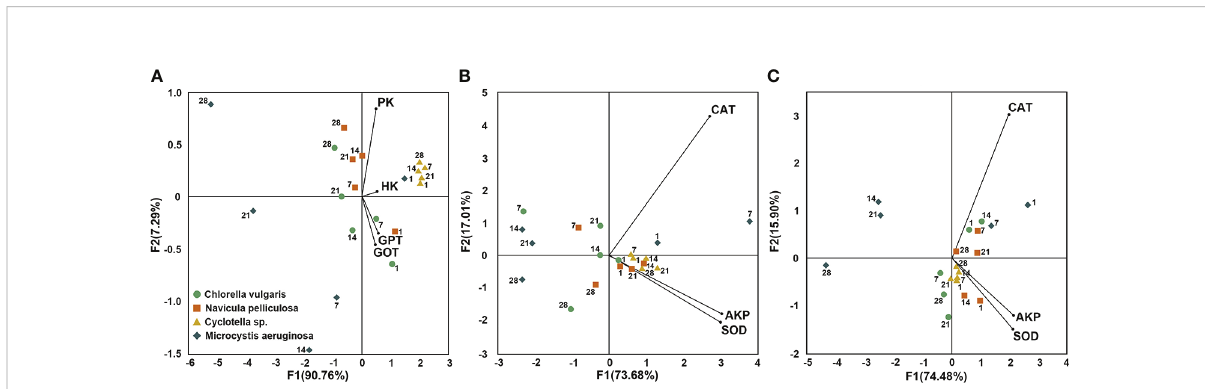
FIGURE 4 Biplot of principal component analysis (PCA) integrating metabolic and immune enzyme activities of Hyriopsis cumingii . (A) PCA for metabolic enzymes in liver, (B) PCA for immune enzymes in serum, and (C) PCA for immune enzymes in gill. Metabolic enzymes: GOT, GPT, PK, and HK. Immune enzymes: AKP, SOD, and CAT. Four microalgae treatments: Chlorella vulgaris , Navicula pelliculosa , Cyclotella sp., and Microcystis aeruginosa . Sampling time points: days 1, 7, 14, 21, and 28. GOT, glutamic oxaloacetate transaminase; GPT, glutamic pyruvate transaminase; PK, pyruvate kinase; HK, hexokinase; AKP, alkaline phosphatase; SOD, superoxide dismutase; CAT,